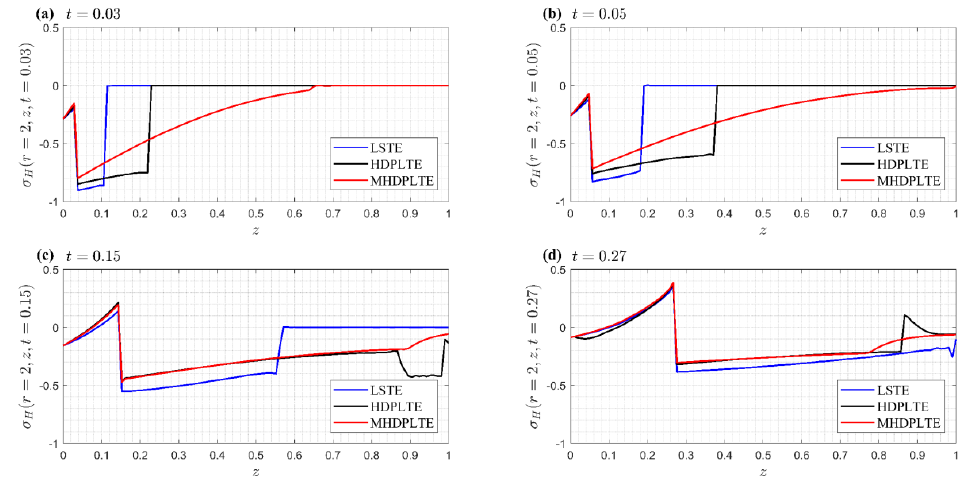
Figure 5. Comparison among the hydrostatic stress profiles resulted from the three thermoelastic models at r = 2 and different instants: ( a ) t = 0.03, ( b ) t = 0.05, ( c ) t = 0.15 and ( d ) t = 0.27.